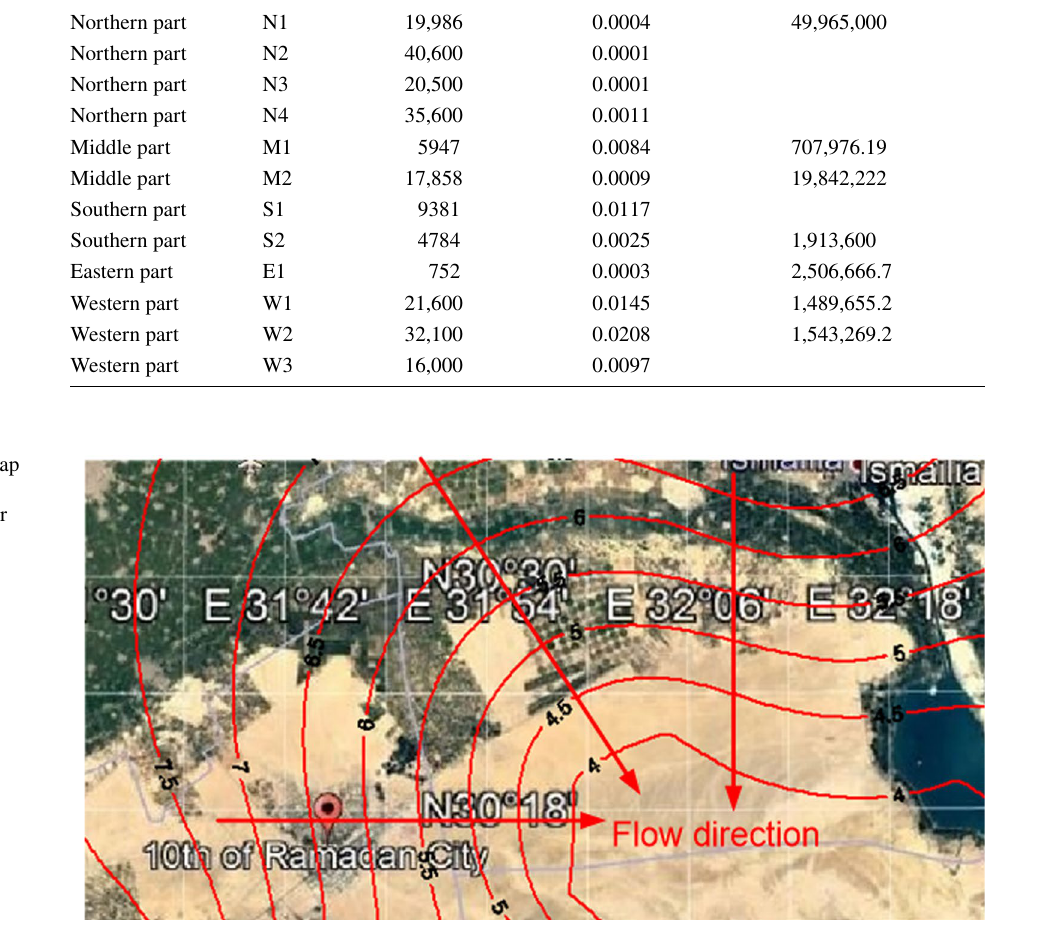
Table 1 Summary of calculating aquifer parameters in the study area. (After Gad 1995)